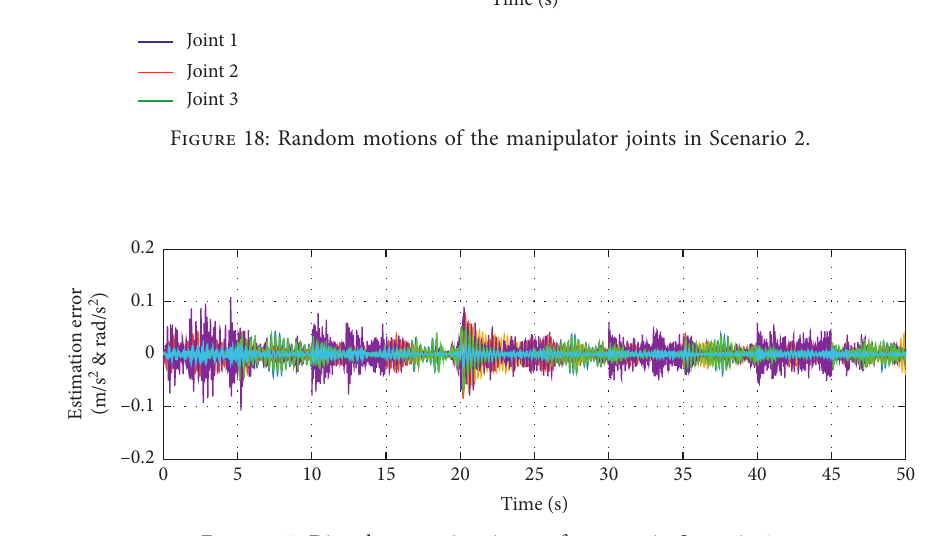
Figure 19: Disturbance estimation performance in Scenario Table 3: RMSE in Scenario 2.